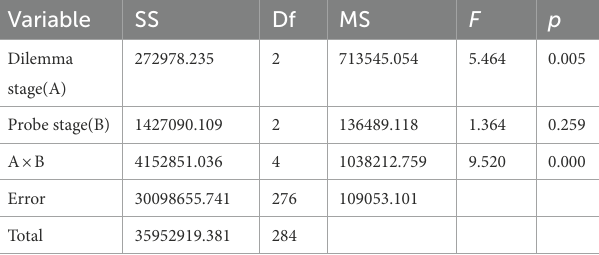
TABLE 3 Repeated-measures ANOVA